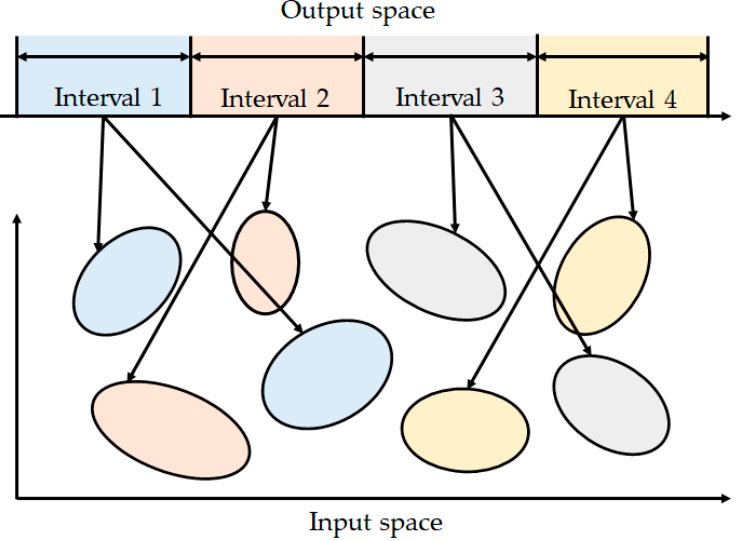
Figure 1. Concept of interval-based fuzzy clustering concept.